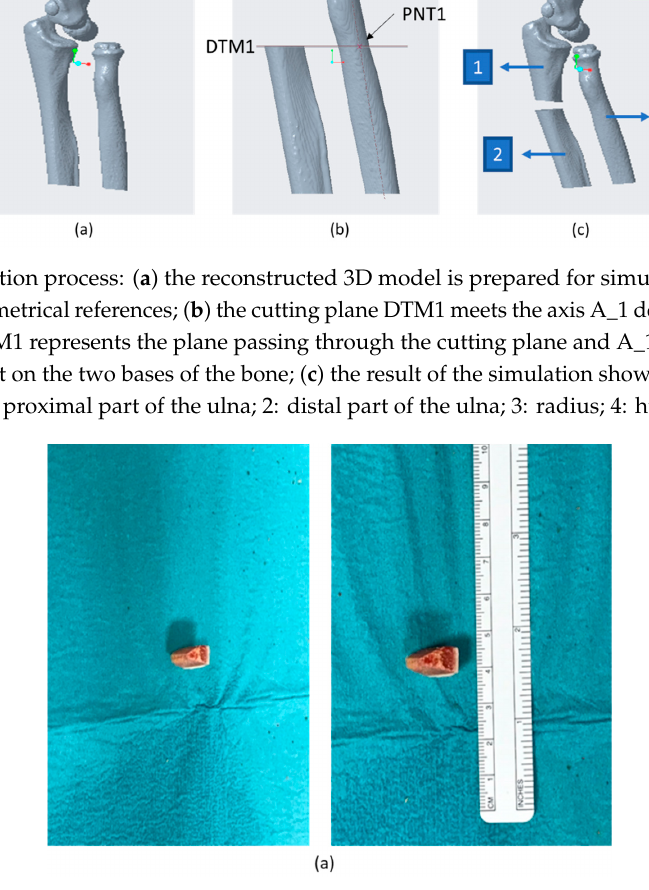
Figure 6. ( a ) The bone allograft was cut according to the preoperative simulation; ( b ) a one-third tubular 3.5 mm locking compression plate was shaped according to the preoperative simulation.